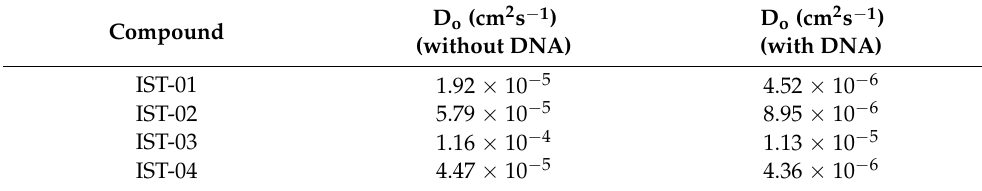
The calculated values of the diffusion coefficient are presented in Table 4. They clearly indicate slow diffusion, with lower diffusion coefficient values for compounds with DNA due to the formation of bulky compound–DNA complexes [42]. Table 4. Diffusion coefficients of compounds before and after the addition of